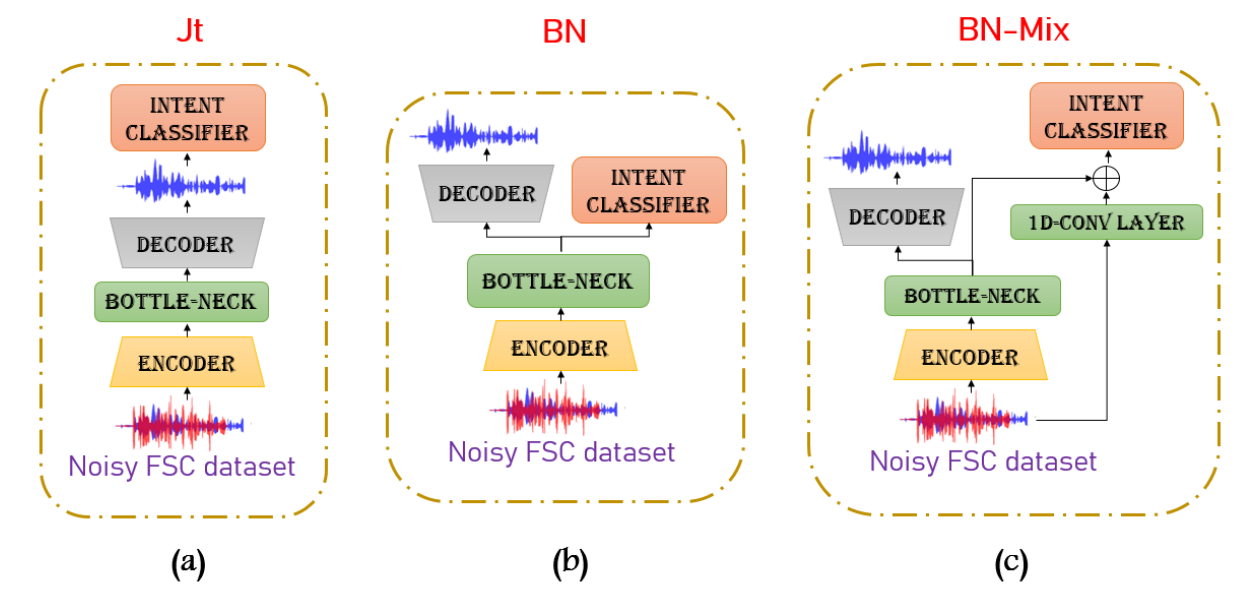
Figure 5. Three strategies of the proposed joint training approaches: ( a ) based on the mixture signals (JT). ( b ) based on bottleneck representation (BN). ( c ) based on the concatenation between mixture signals and bottleneck representation